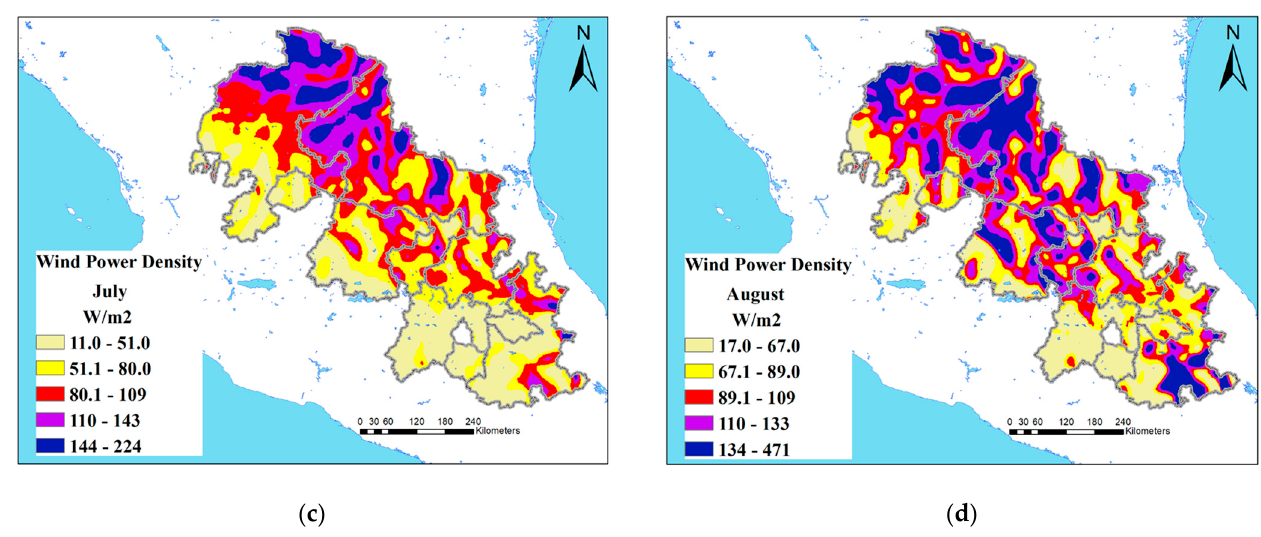
Figure 15. WPD in Central Mexico in ( a ) May, ( b ) June, ( c ) July and ( d ) August. The maps obtained in the months shown in Figure 15 show a windy season from June to August in the states of Zacatecas and San Luis Potosí. The WPD in September, October, November, and December are presented in the maps in Figure 16.